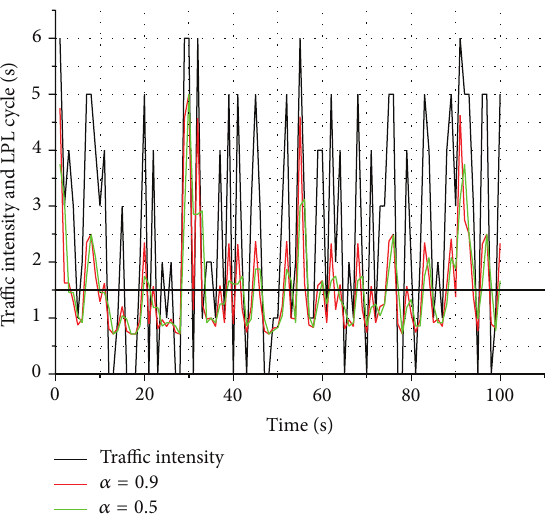
Figure 4: LC variation versus traffic intensity.